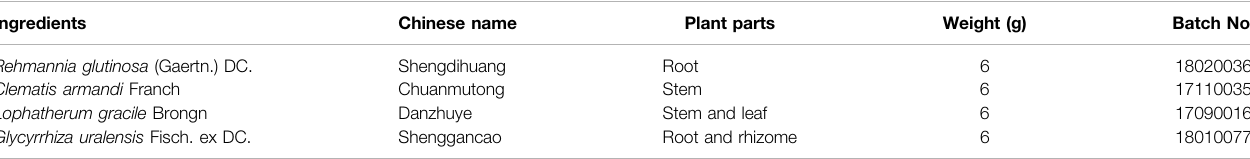
TABLE 2 | The ingredients list of Dao-Chi powder.